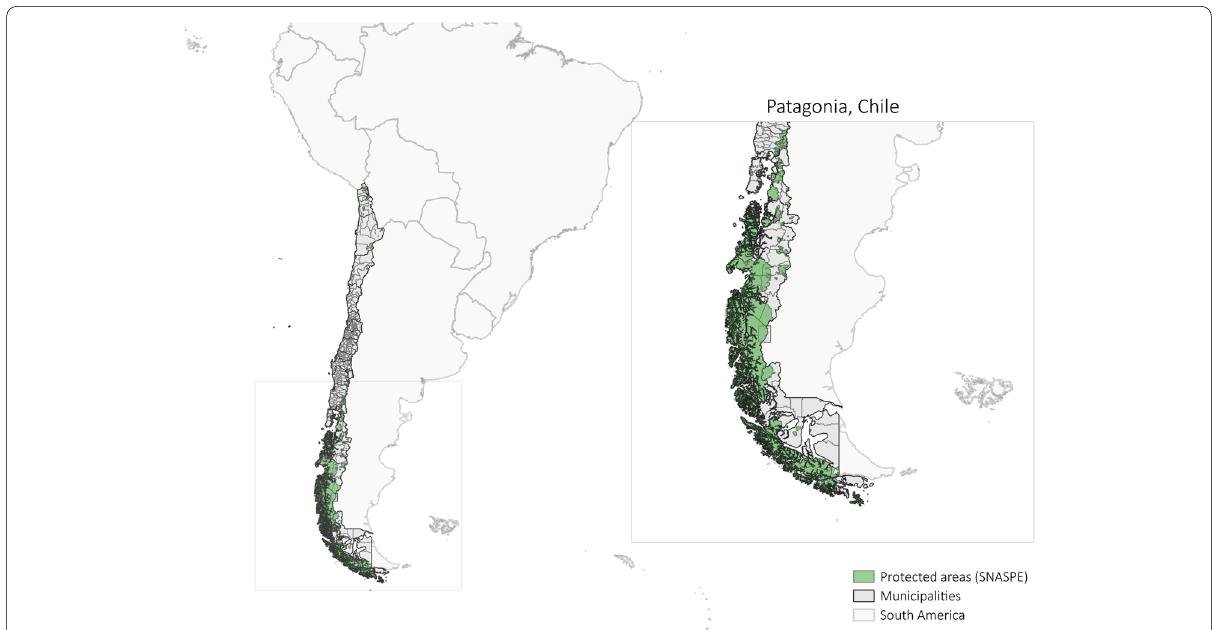
Fig. 1 Terrestrial protected areas in Chile. To the best of our knowledge, there is no formal geographic definition of Patagonia in Chile. In this study, we define Chilean Patagonia as the area that encompasses the regions Los Lagos, Aysén del General Carlos Ibáñez del Campo, and Magallanes and Chilean Antarctica. This geographic delimitation was based on personal communication with researchers in Chile. SNASPE is the acronym in Spanish for the national state system of protected areas managed by the Corporación Nacional Forestal (CONAF). It is composed of the following categories National Parks, National Reserves, and Natural Monuments. Natural Sanctuaries, another terrestrial protected area category, are not part of the SNASPE and were not included because of their limited total surface, most of them are recently created and their administration is limited in comparison to the SNASPE. See Table S3 in the Additional Material file for the complete list of the protected areas considered in this study as well as the year these protected areas were created by the State. The analysis focused only on terrestrial protected areas from SNASPE